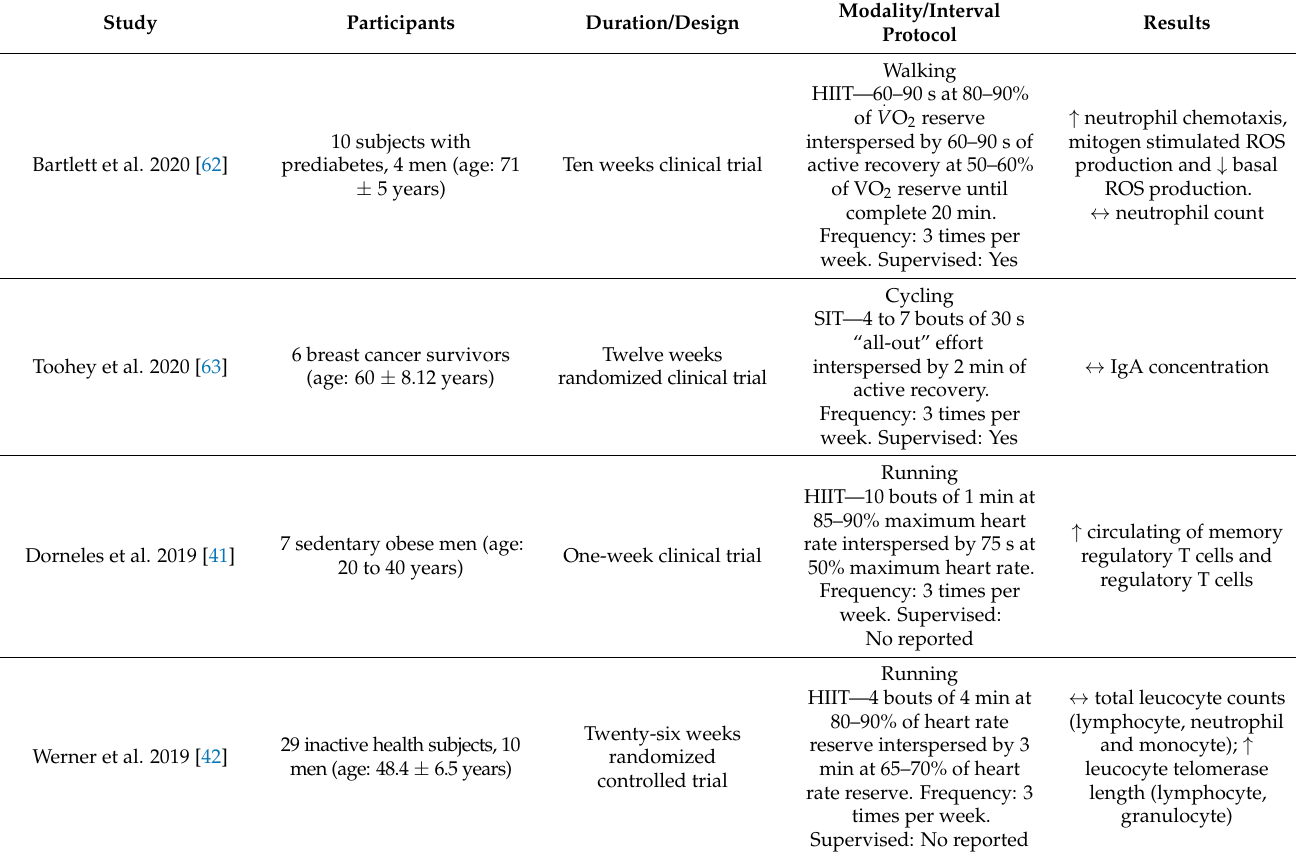
Table 2. Summarize of studies investigating the chronic effects of interval training on immune